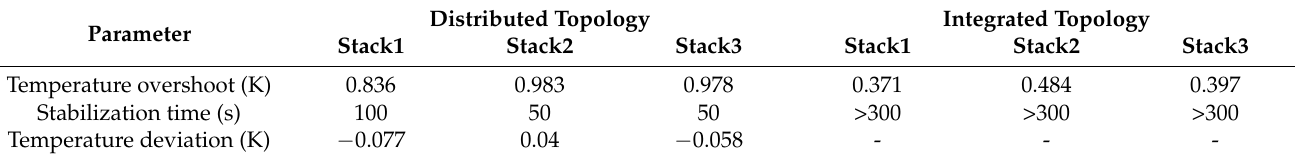
Table 2. The detailed comparison of the two topologies under steady working conditions.